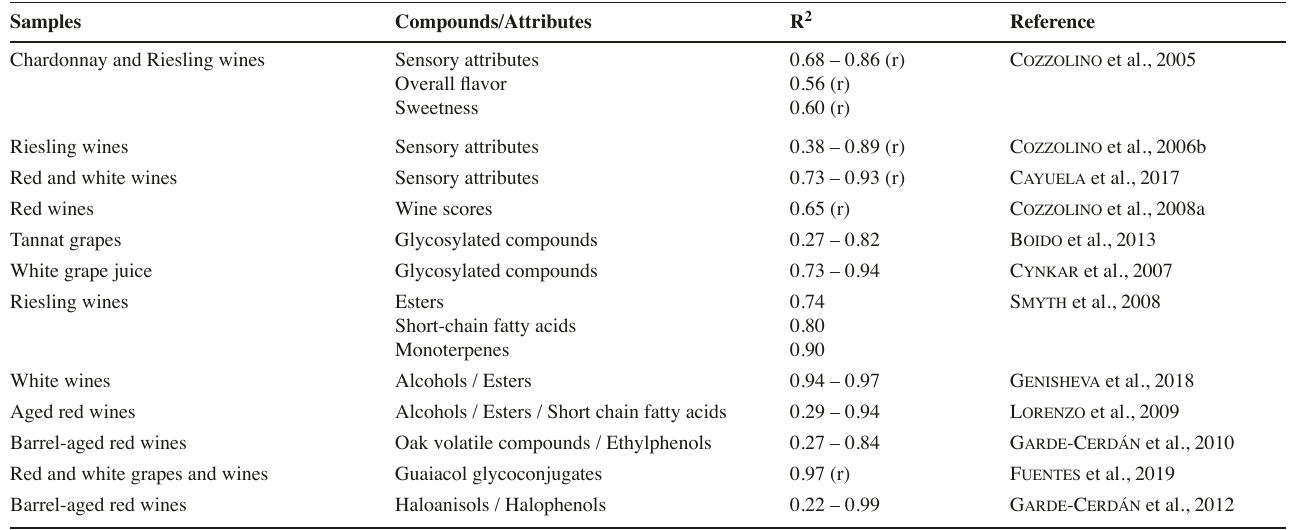
Tab. 3: Applications of NIR spectroscopy in the evaluation of grape and wine aroma